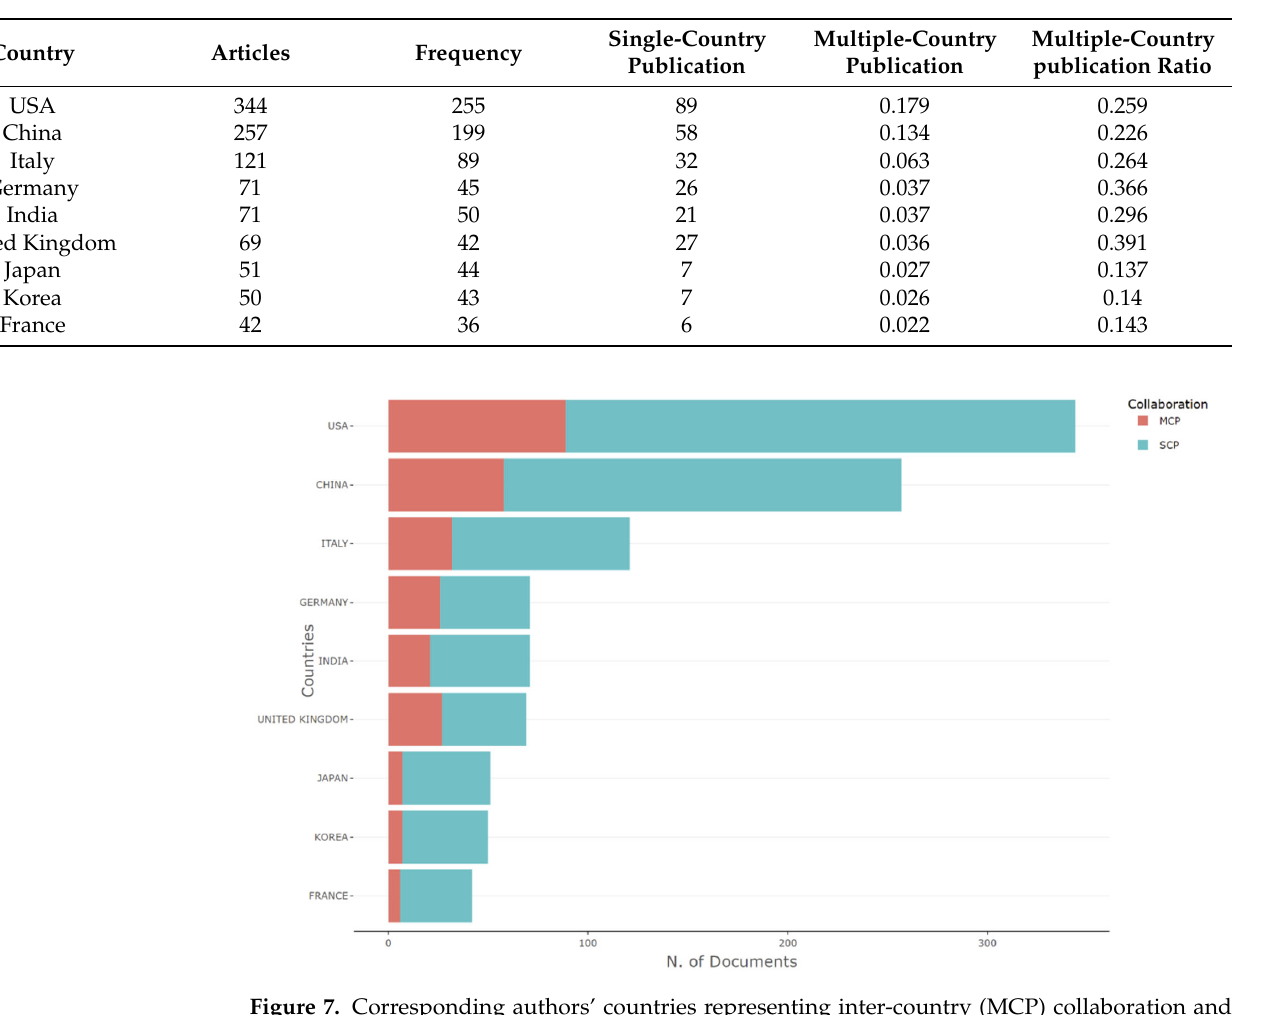
Table 3. Top ten globally cited authors.